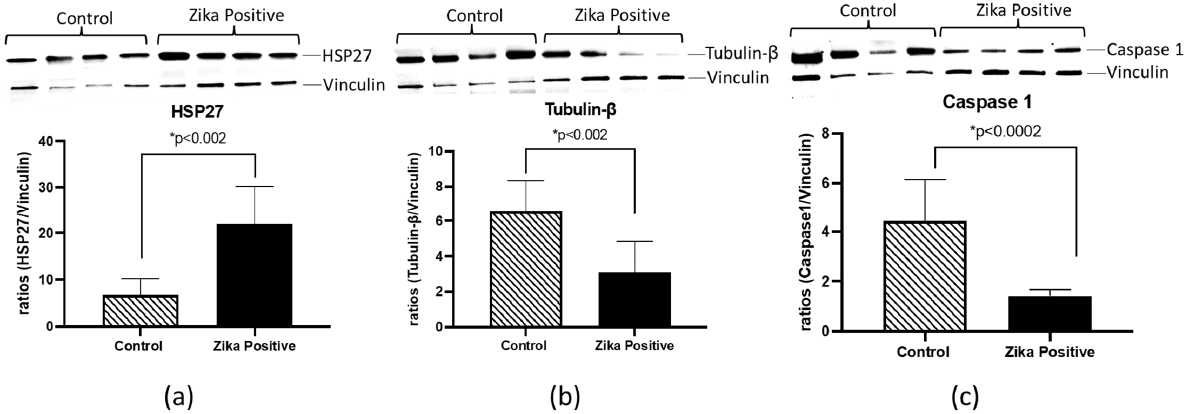
Figure 6. Validation of proteomics data of differentially expressed proteins from ZIKV-positive and negative frozen placentas by western blot. From left to right, we have the densitometry analysis of HSP27, TUBB, and CASP1. Results from relative intensity analysis of protein of interest and representative western blot bands (top of each figure) for this experiment are shown in ( a – c ). Relative